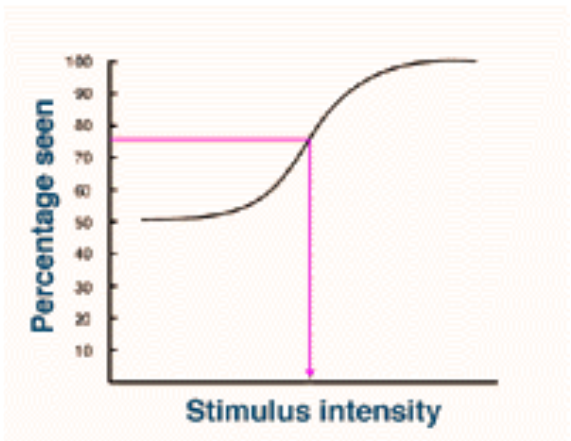
Figure 3 . A 2AFC psychometric function with the threshold at 75% is shown (Reproduced with permission from Webvision) 5